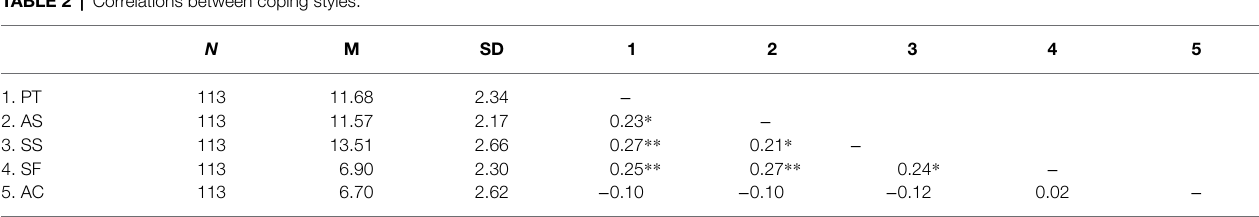
TABLE 2 | Correlations between coping